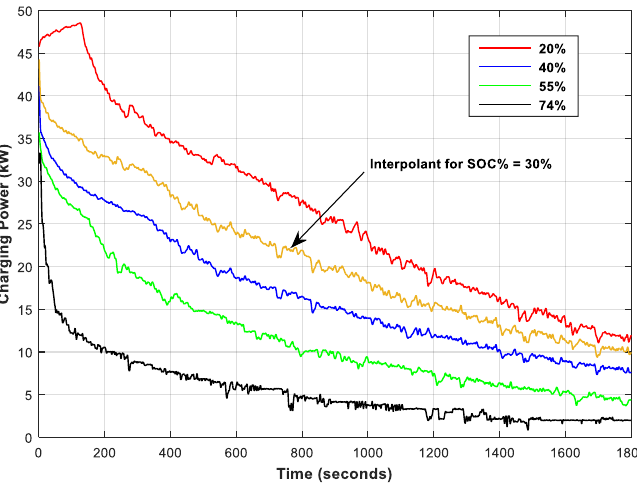
Figure 9. The interpolated power profile for SOC = 30%.